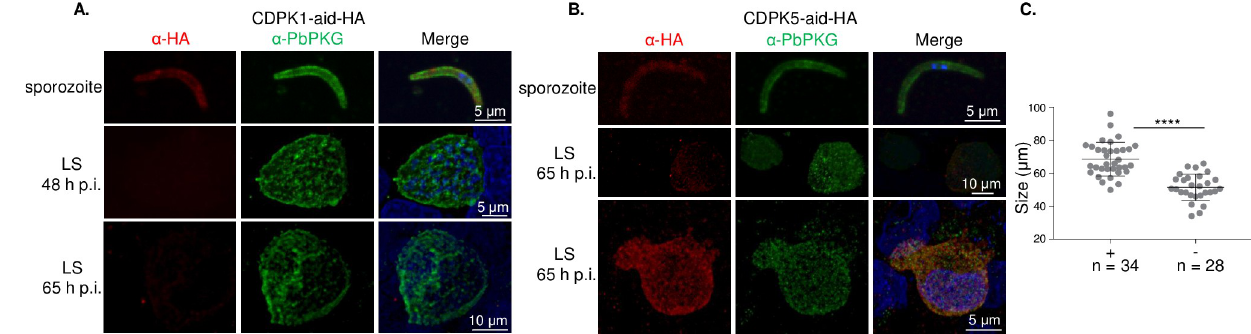
Fig 1. Spatial and temporal localization of CDPK1 and CDPK5 in P . berghei pre-erythrocytic stages. A) Representative images of CDPK1 localization in pre-erythrocytic stages of CDPK1-aid-HA parasites determined using an anti-HA antibody. CDPK1 was detected in sporozoites but not in liver stages. B) Representative images of CDPK5 localization in pre-erythrocytic stages of CDPK5-aid-HA parasites determined using an anti-HA antibody. CDPK5 was detected in all sporozoites and in a subset of mature liver stages (65 h p.i.). C) Diameter of individual CDPK5-aid-HA liver stages ( μ M ± SEM), that either displayed staining with anti-HA antibody at 65 h p.i. ( ± ) or not (-) was determined. Data were analyzed using an unpaired t -test, ���� P value < 0.0001.